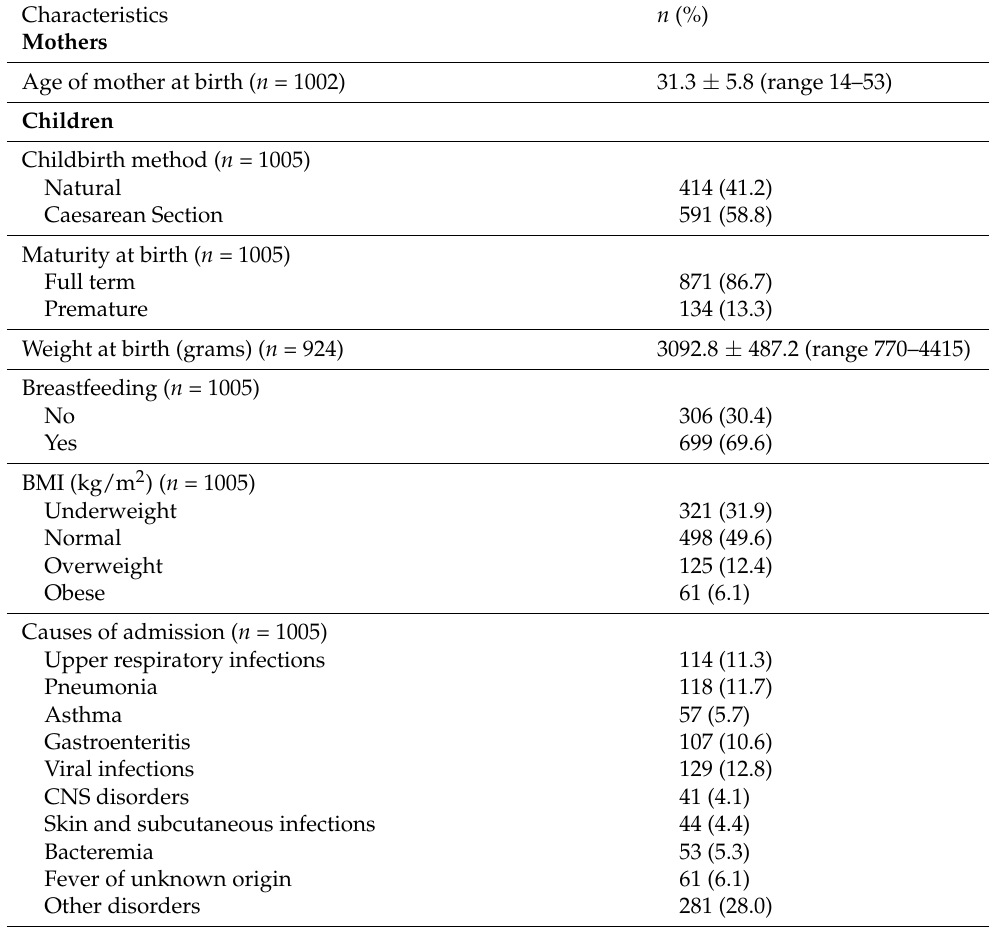
Table 2. Characteristics of the mothers and the children. BG: Blood Glucose; BMI: Body Mass Index, and CNS: Central Nervous System. Values are presented as n (column %) or mean (standard